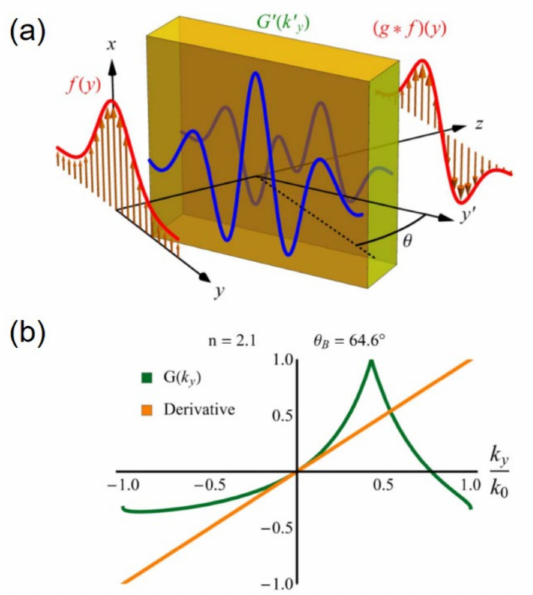
Figure 10. ( a ) The schematic of the rotated structure for realizing an even or odd Green’s function; ( b ) the exact GF distribution and its approximation around k y = 0 based on the Taylor series. Adapted with permission from [148] © The Optical Society.